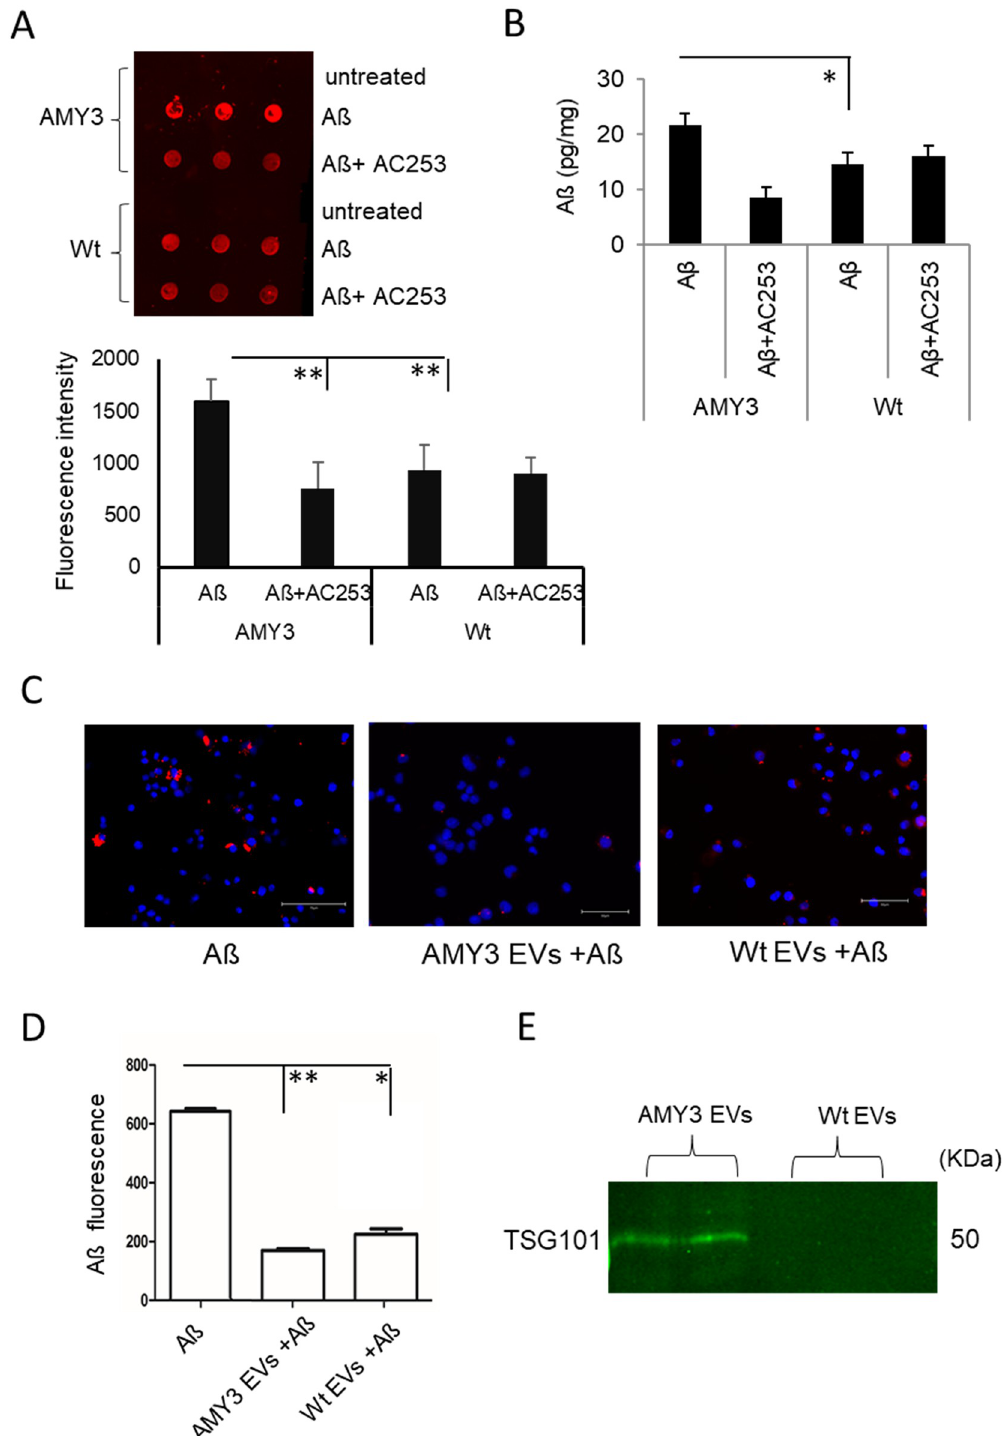
Fig 3. HEK AMY3 derived EVs bind to Aß though AMY receptors expressed on N2a cells in vitro . A , Dot blots (top panel) showing EVs generated from AMY3 cells bind Aß to a greater degree than EVs from Wt cells. Preincubation with the amylin receptor antagonist, AC253, blocks Aß binding to EVs derived from AMY3, but not those from Wt cells. A β levels in the EVs were measured from dot blots with an A β antibody (6E10) and a fluorescently labeled secondary antibody. EVs not treated with Aß were used as controls. Histograms (lower panel) showing quantification of mean fluorescence of A β in EVs (Data